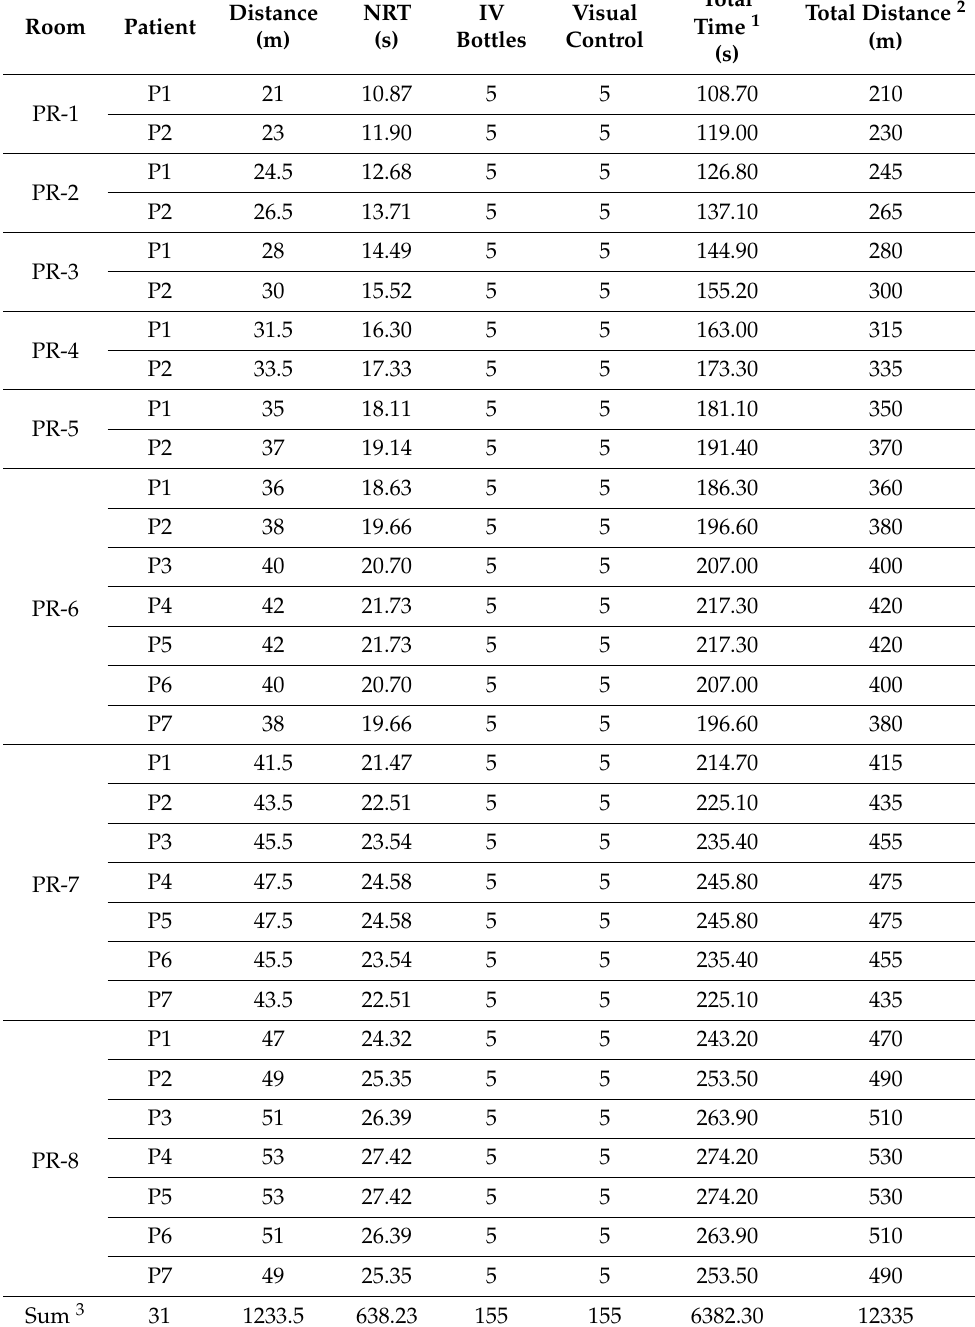
Table 3. Nurse response time